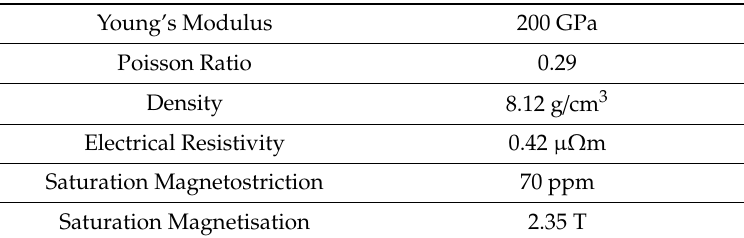
Table 1. Mechanical and magnetic characteristics of the magnetostrictive patch material (VACOFLUX iron-cobalt alloy).